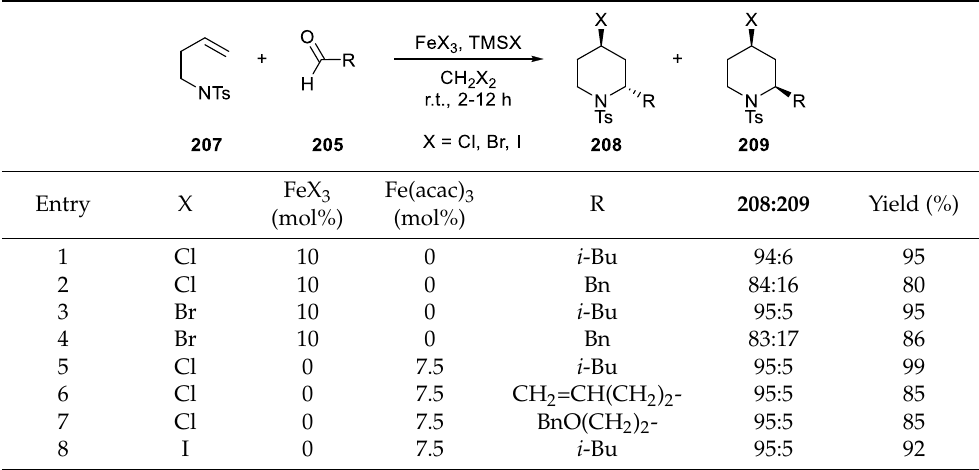
Molecules 2023 , 28 , x FOR PEER REVIEW Table 6. Iron-catalyzed Prins cyclization of homoallyl tosyl amines. Table 6. Iron - catalyzed Prins cyclization of homoallyl tosyl